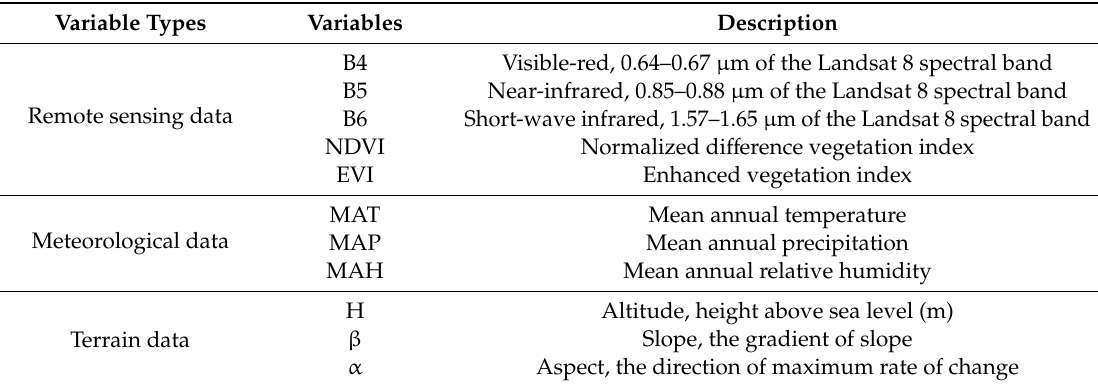
Table 1. Environmental variables for wetland soil organic carbon concentration (SOCc)